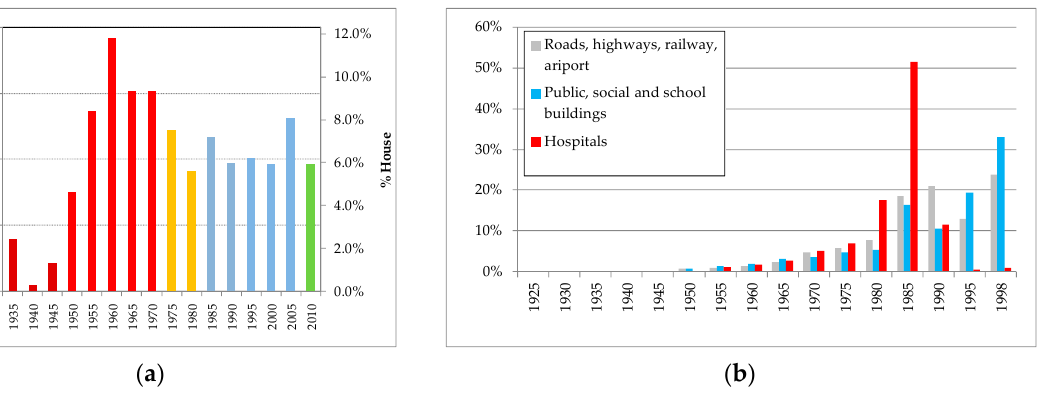
Figure 1. Residential buildings and main civil engineering works: ( a ) distribution according to age of the houses built; different colors refer to different Italian codes and/or new and significant seismic classification; ( b ) distribution of financial resources for engineering works that are totally or partially state-funded (source: www.istat.it (accessed on 24 January 2022)).